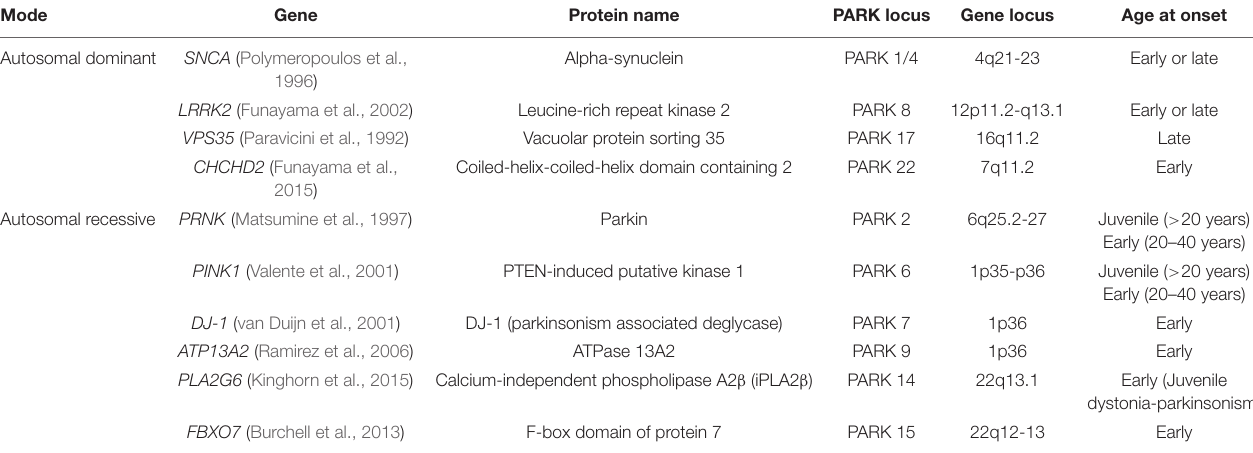
TABLE 1 | Mitochondrial dysfunction-related genes in Parkinson’s